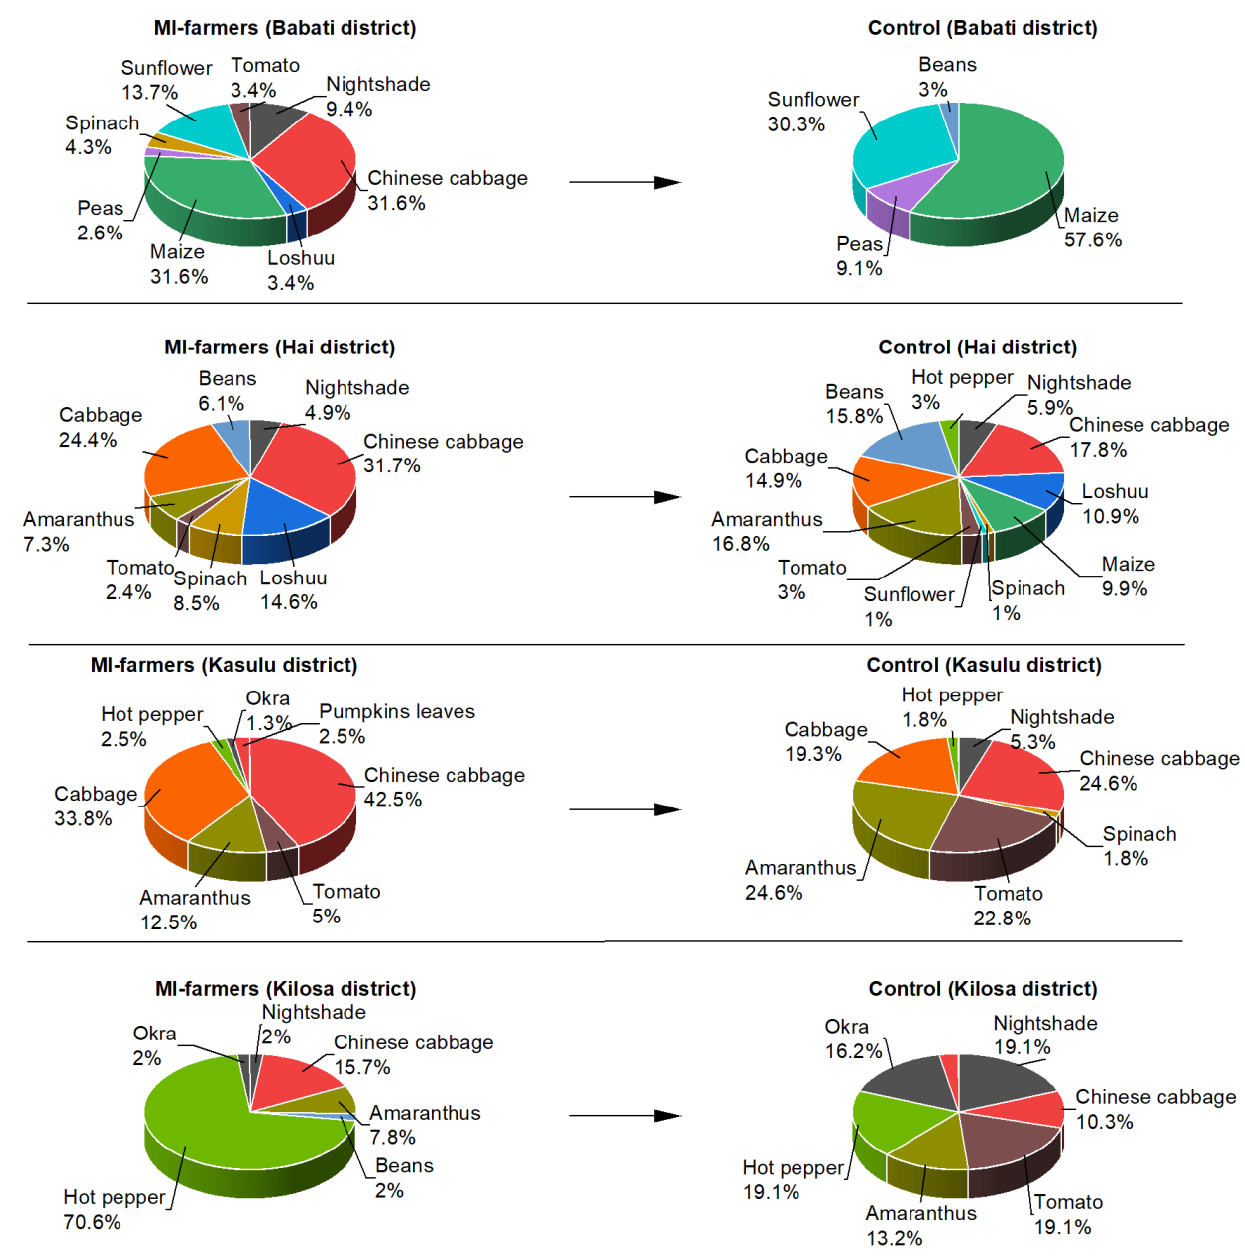
Figure 2. Micro-investing (MI) and control farmers (%) producing crops and vegetables in all four study districts in Tanzania.